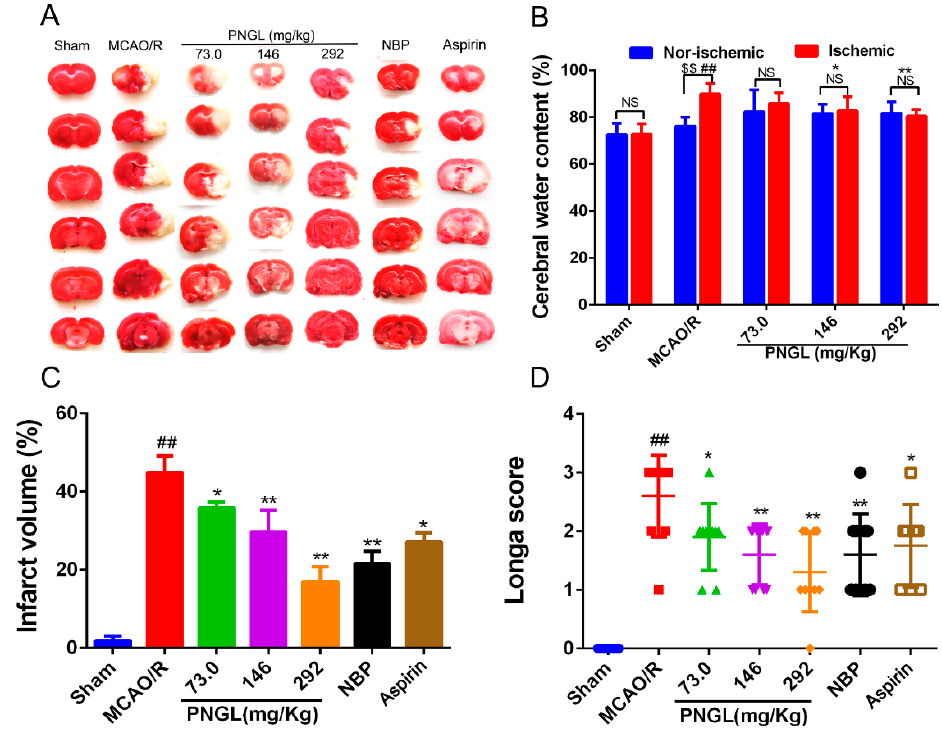
Figure 3. Effects of PNGL on infarct volume, brain water content, and neurological deficit scores in MCAO/R injury rats. PNGL improves neurological functions and attenuate brain swellings and infarcts in MCAO/R rats. ( A ) Representative images of 2, 3, 5-triphenyltetrazolium chloride -stained brain sections from the sham-operated or PNGL-treated animals collected 24 h after infarction; red tissue is healthy; white tissue is infarcted ( n = 3–6 in each group). ( B ) Brain water content in ischemia hemispheres of all groups ( n = 4 in each group). ( C ) Quantitative analysis of the infarct volume (n = 3 in each group). ( D ) Neurological deficit scores in all groups ( n = 10 in each group). Mean values ± SD; * p < 0.05, ** p < 0.01 versus MCAO/R group; # p < 0.05, ## p < 0.01, versus sham group; $$ p < 0.01, Nor-ischemic versus Ischemic; NS means no significance, Nor-ischemic versus Ischemic.